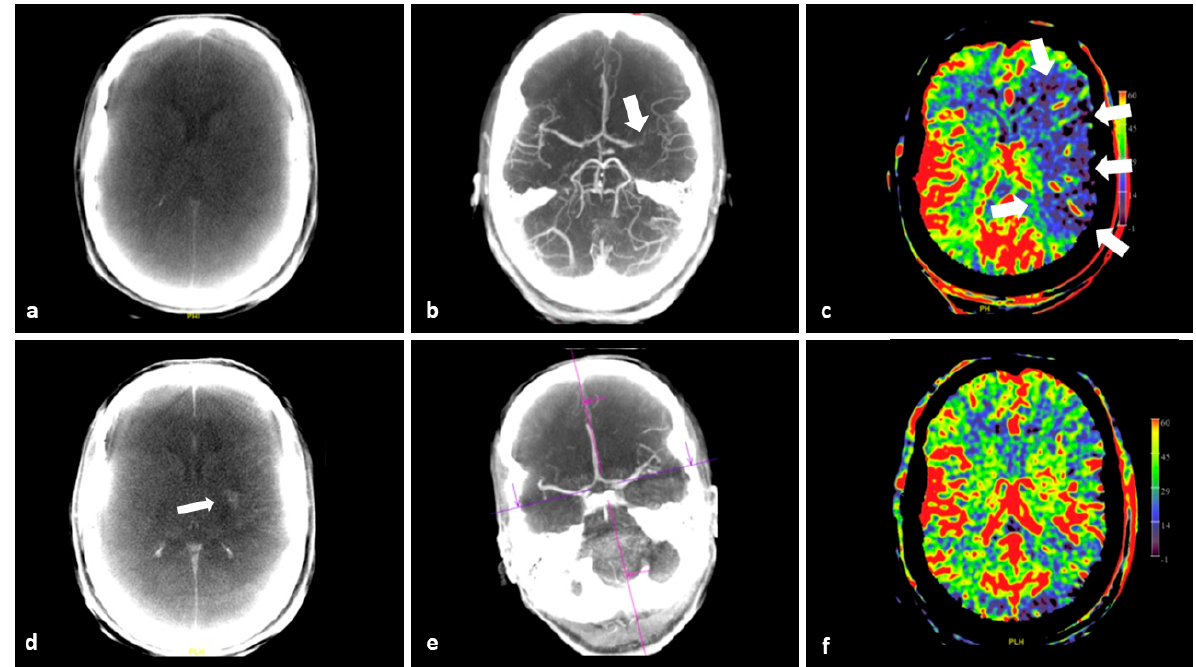
Figure 2. FD CT imaging in a 44-year-old female with AIS due to LVO, referred for EVT. ( a ) Pre intervention axial MIP reformation of the mask run demonstrates no hemorrhage. ( b ) Pre intervention axial MIP reformation shows occlusion at the level of M1-segment of the left MCA (arrow). ( c ) PBV MIP reformation features a perfusion deficit in the left MCA supply area (arrows). ( d ) Post EVT axial mask run MIP reformation demonstrates small area of contrast pooling in the left lentiform nucleus and the revascularized MCA territory (arrow). ( e ) Post EVT axial fill run MIP reformation confirms recanalization. ( f ) Post EVT axial PBV MIP reformation shows restoration of CBF with (almost) symmetrical PBV map.